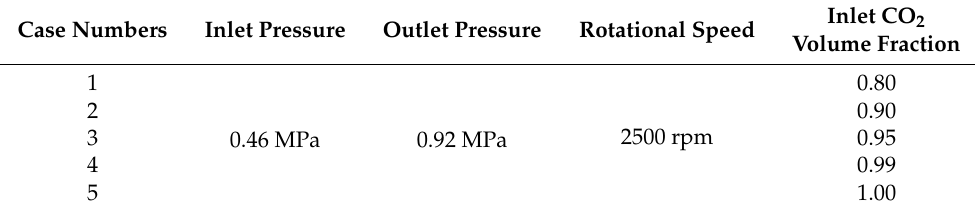
Table 4. Operating conditions with various inlet CO 2 volume fractions.